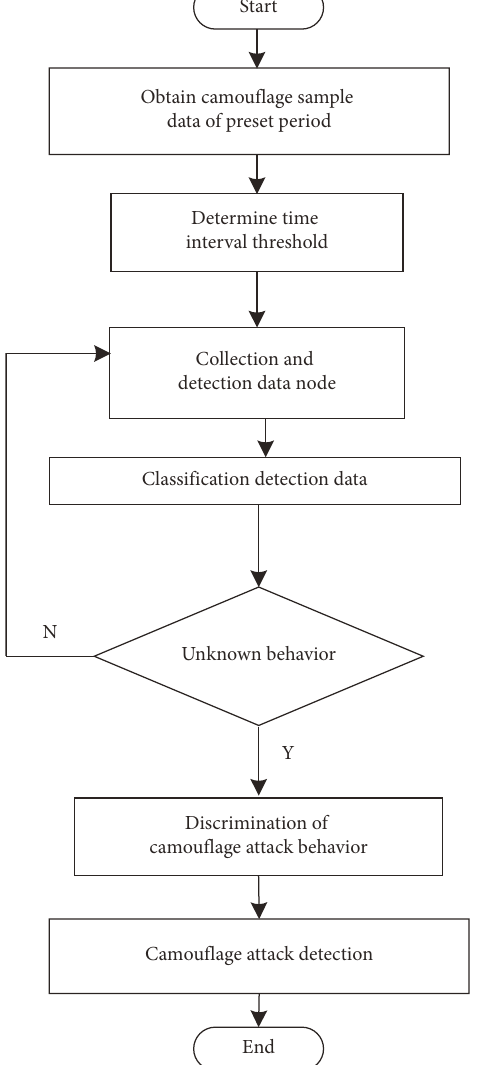
Figure 2: Camouflage data mapping processing